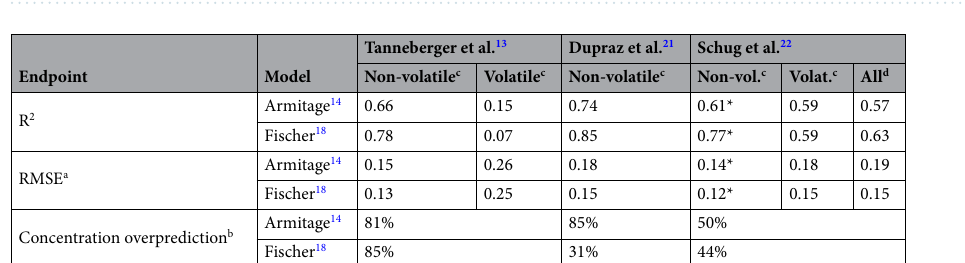
Armitage 14 81% 85% 50% Concentration overprediction b Fischer 18 85% 31% 44% Table 1. Analysis of the Fischer and Armitage models based on the literature data. *Only five data points available and three of them did not present any loss in the medium a Root Mean Square Error. b States for how many chemicals (in %) model predicted higher medium concentration than it was measured. c Volatile chemicals: logHLC > − 5.61, according to Tanneberger et al. 13 . d Due to insufficient number of non-volatile chemicals (five, of which three did not present any loss over time regarding their medium concentration, see*), volatile and non-volatile chemicals were also analysed together.